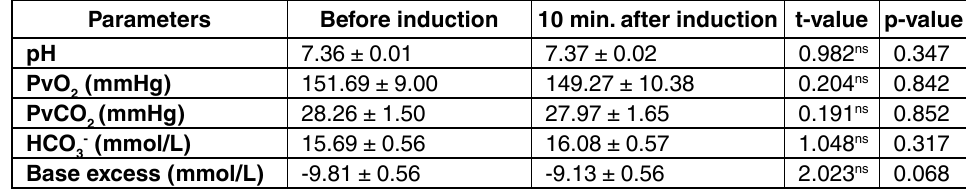
Table 3. Comparison of blood gas parameters before anaesthetic induction and 10